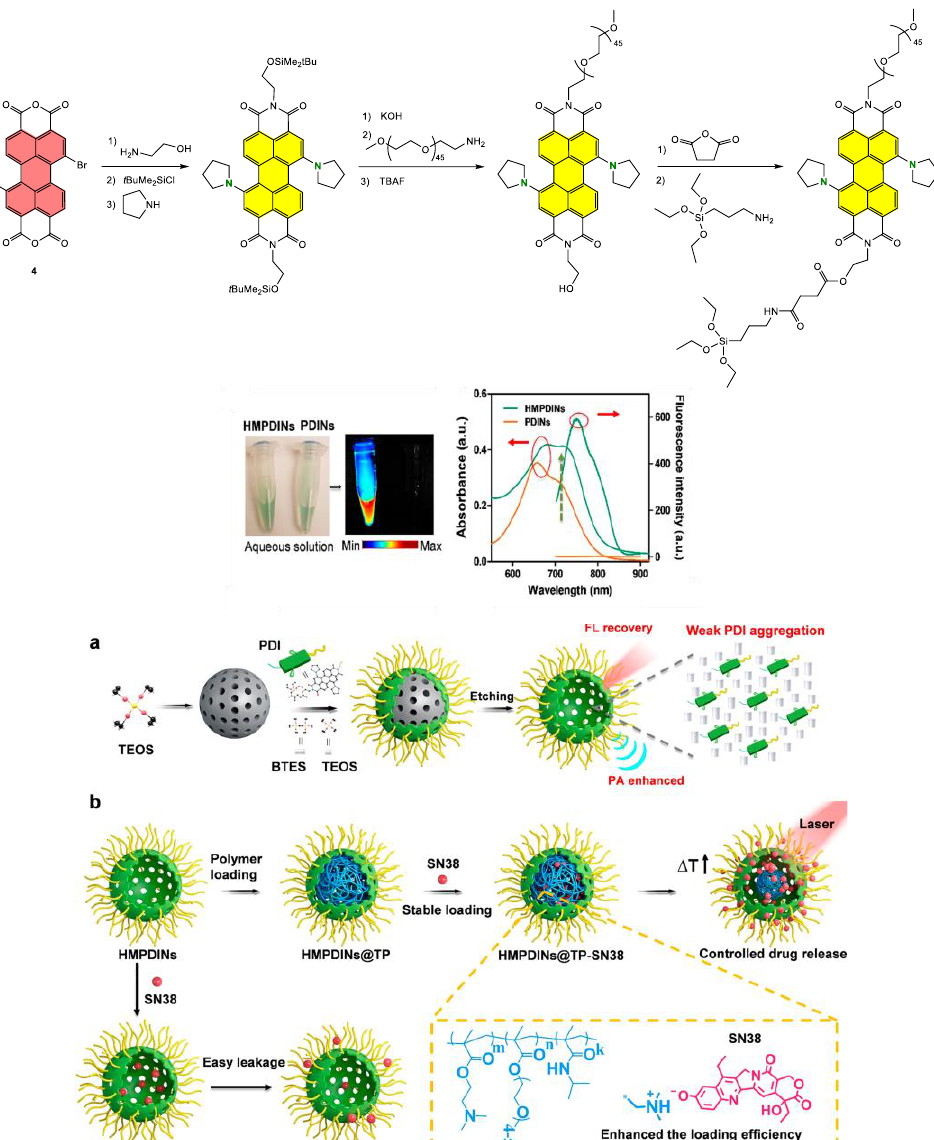
Figure 26. Synthetic strategy for the PEG 2000 -PDI-silane; PBS solutions of HMPDINs and PDINs and their fluorescence-imaging signal ( left ) with their UV–Visible and fluorescence-emission spectra ( right ); ( a ) synthetic route of HMPDINs and the mechanism for the recovered fluorescence and enhanced photoacoustic imaging properties, ( b ) scheme of the polymerization within HMPDINs for photocontrolled drug release. Reprinted with permission from reference [137]. Copyright 2019 American Chemical Society.